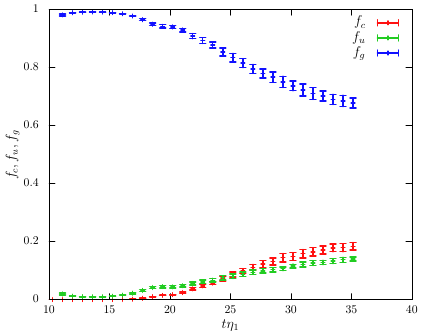
Figure 12 . The time-evolution of the fraction f c , f u , and f g , for ( q 1 ; q 2 ; (cid:17) 2 =(cid:17) 1 ) = (1 ; 4; 0 : 25). be free from the axion domain-wall problem (see discussion in section 5). In the 3+1 D, however, the string combination processes are less e(cid:14)cient, and hence, it is imperative to estimate how large fractions of the strings have j N dw j > 1 at late times in the 3+1 D